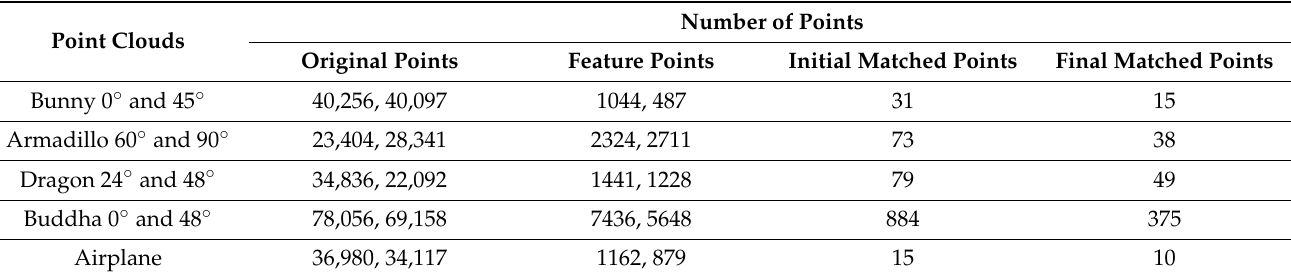
Table 5. Comparison of numbers in each processing